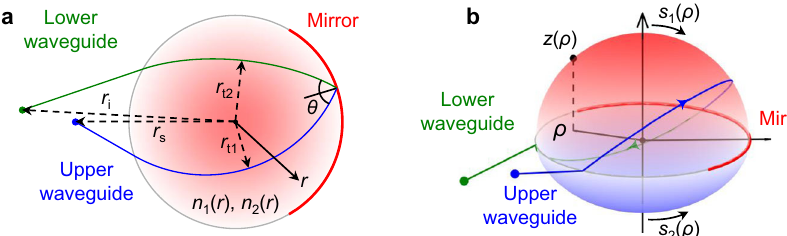
Fig. 1 Schematic of the 2D double-layer lens problem. a Graded index double-layer lens de fi ned under polar coordinate system ( r , ϕ ). Incident rays from a point source at r = r s in upper waveguide are fi rst refracted by the pro fi le n 1 ( r ) before encountering the mirror on the far side of the device. The mirror re fl ects the ray into a lower waveguide where it is refracted by the pro fi le n 2 ( r ), focusing all rays to a point image at r = r i . The thickness of the waveguides is neglected in fi rst approximation for the purposes of this development, considering it is small compared to the wavelength. b Equivalent geodesic double- layer lens, where the refractive index is placed with an out of plane deformation z ( ρ ) of the upper/lower waveguide described by the arc length s 1,2 ( ρ ) of the surface measured along the meridian from the axis of symmetry under a cylindrical coordinate system ( ρ , ϕ , z ). In both cases, the background medium outside the lens has refractive indices n a and n b for the upper and lower